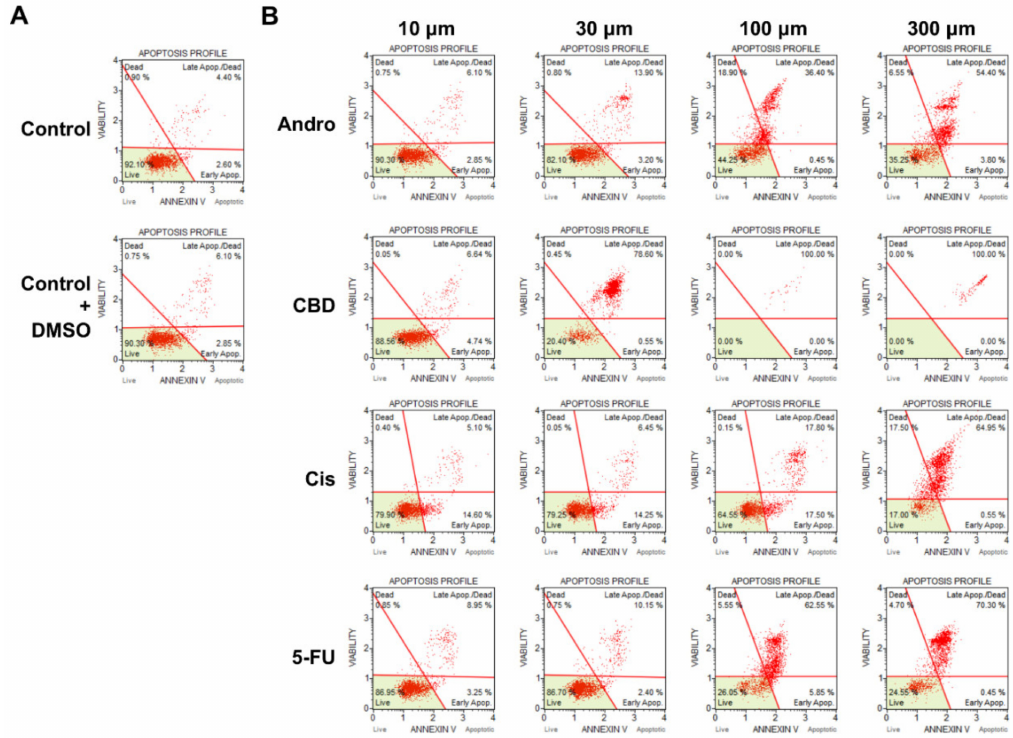
Figure 6. Apoptosis analyzed by flow cytometry following Annexin V / 7-AAD binding assays. ( A ) Two negative control groups were used: cells without drug treatment and cells treated with DMSO. ( B ) SCC-25 cells were treated for 24 h at four di ff erent concentrations of andrographolide, CBD, cisplatin, and